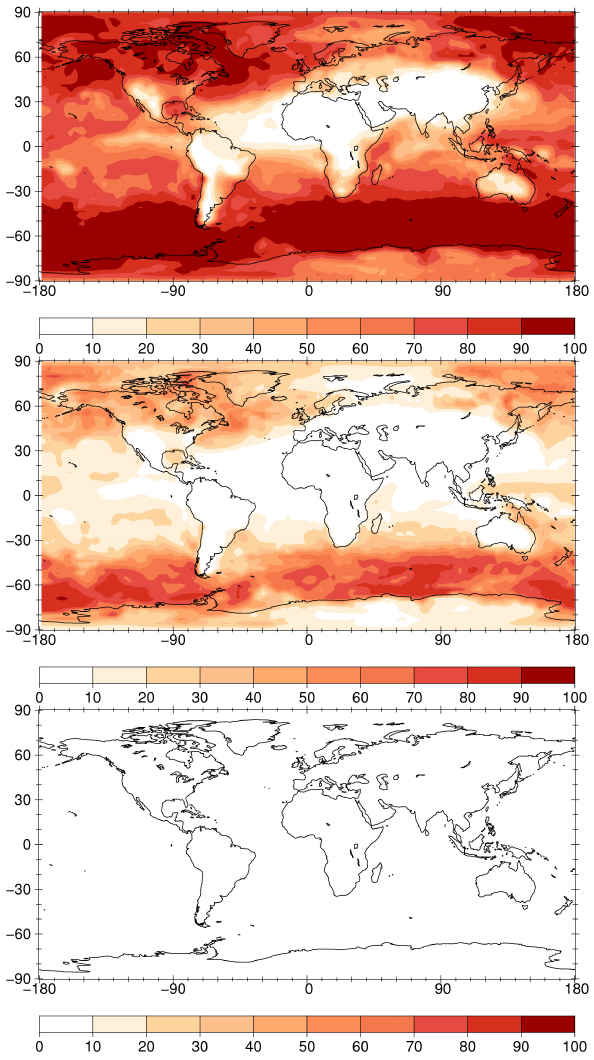
Fig. 5. Simulated relative contribution of marine biogenic IN to ma- rine boundary layer IN concentrations at − 15 ◦ C, as a percent of an- nual mean dust IN and marine biogenic IN. Middle: estimate using “control” dust IN concentrations and “best” biogenic IN concentra- tions; Top: with “high” biogenic IN concentrations; Bottom: with “low” biogenic IN concentrations. For zonal mean comparison of simulated marine IN and dust IN, see Figu. 7.